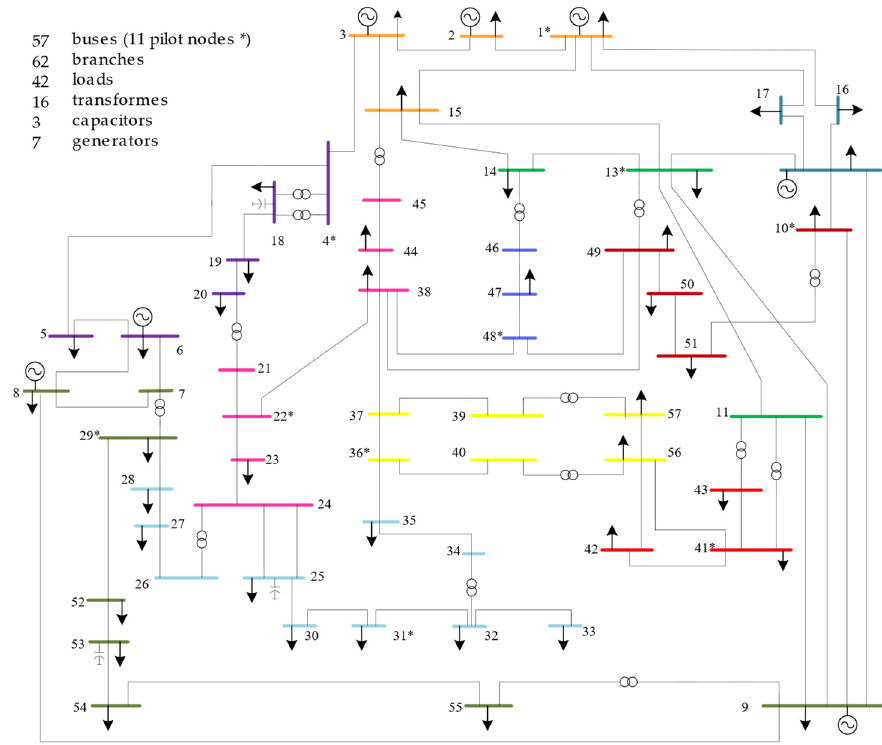
Figure 2. IEEE-57 single-line diagram, annotated with pilot nodes and voltage control areas .